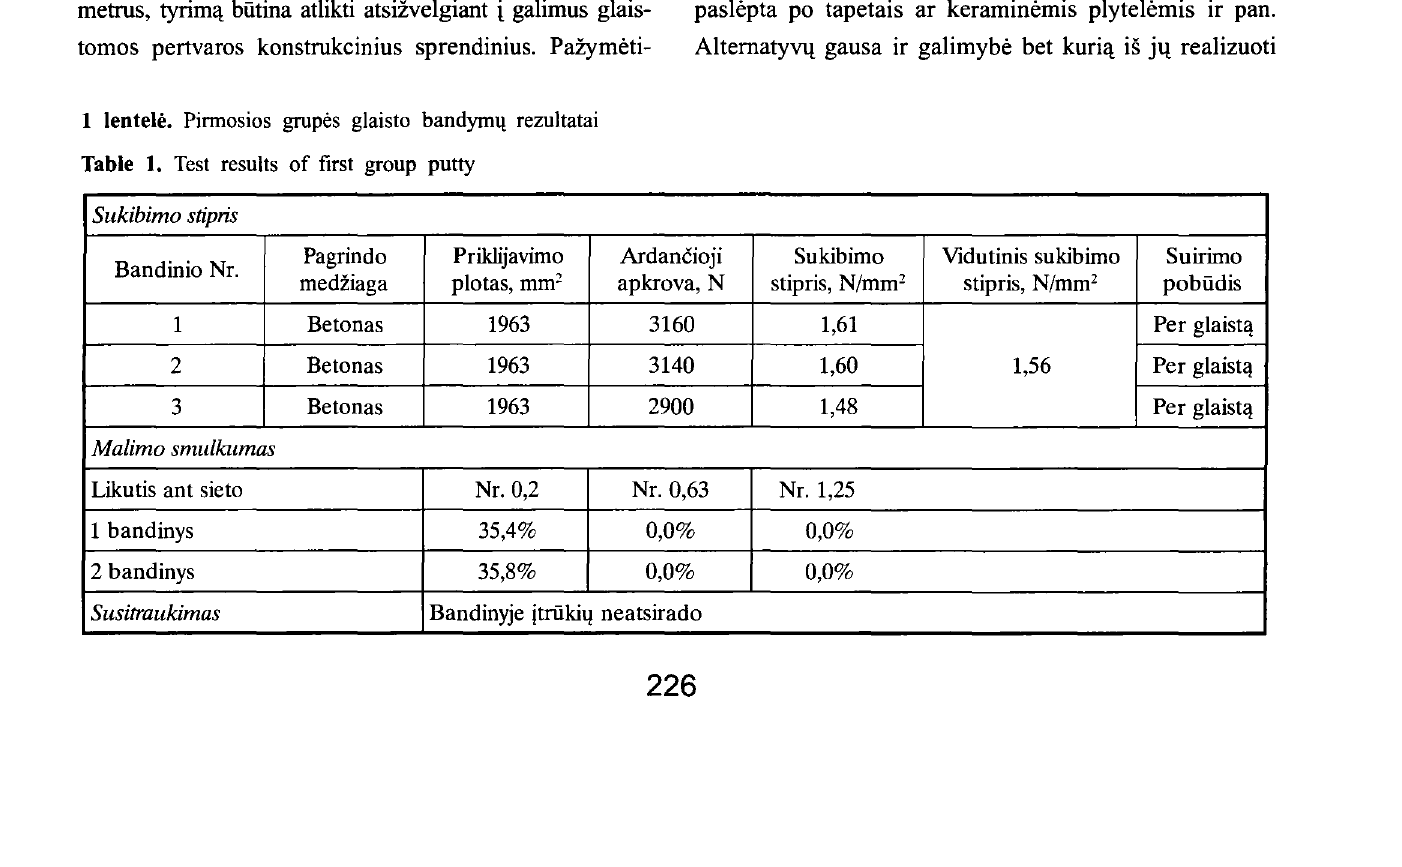
Table 1. Test results of first group putty Sukibimo